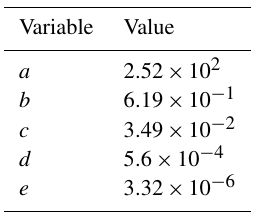
Table 1. Fit coefficients for the MSA volatility parameterization